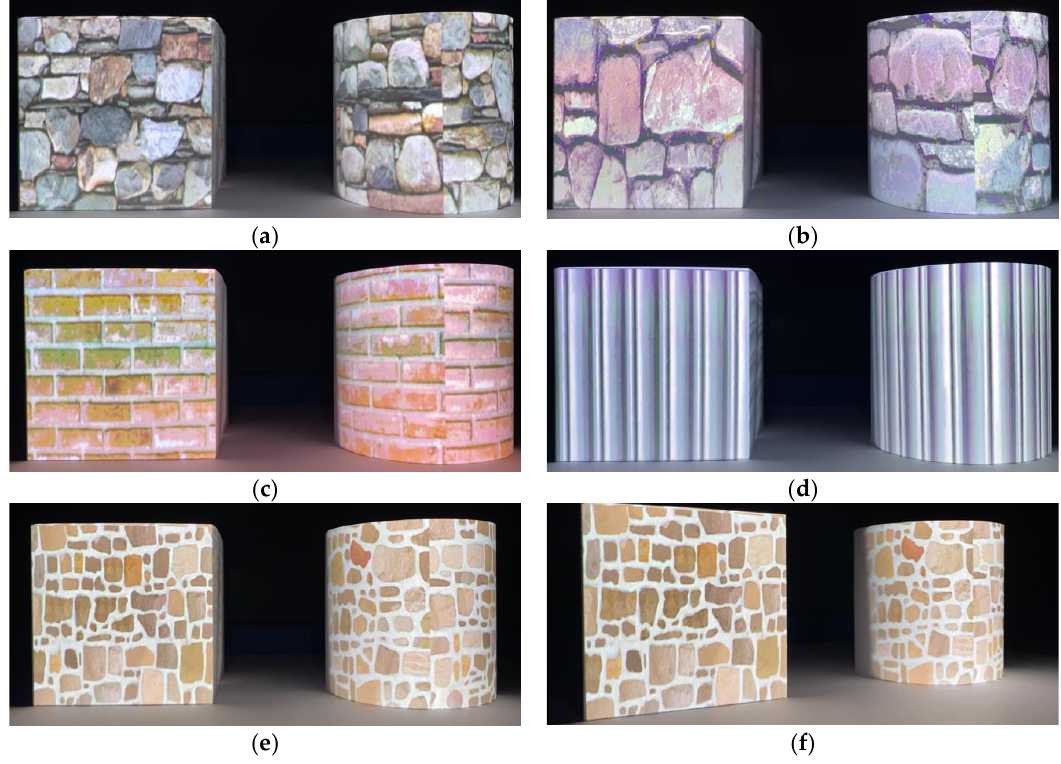
Figure 7. Comparison of projection results on planar/curved surfaces with various building textures. ( a , b , e , and f ) Building textures of stone; ( c ) Building texture of brick; ( d ) Building texture of column pattern.